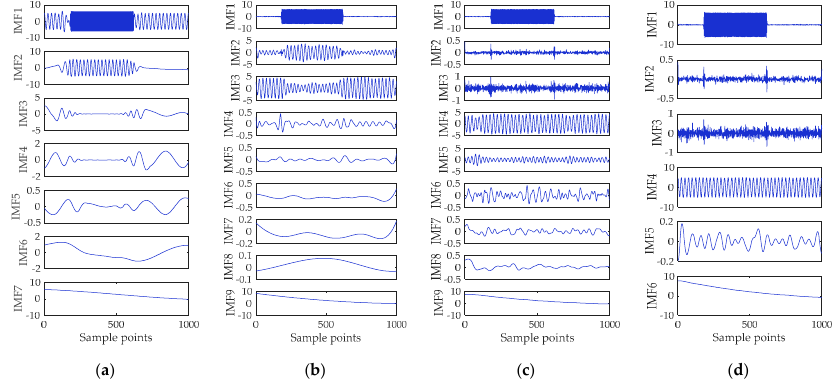
Figure 3. Decomposition results of simulated signal by ( a ) empirical mode decomposition (EMD); ( b ) complementary ensemble EMD (CEEMD); ( c ) complete ensemble EMD with adaptive noise (CEEMDAN); and ( d ) modified CEEMDAN (MCEEMDAN). Table 1. The decomposition performances of these decomposition algorithms.